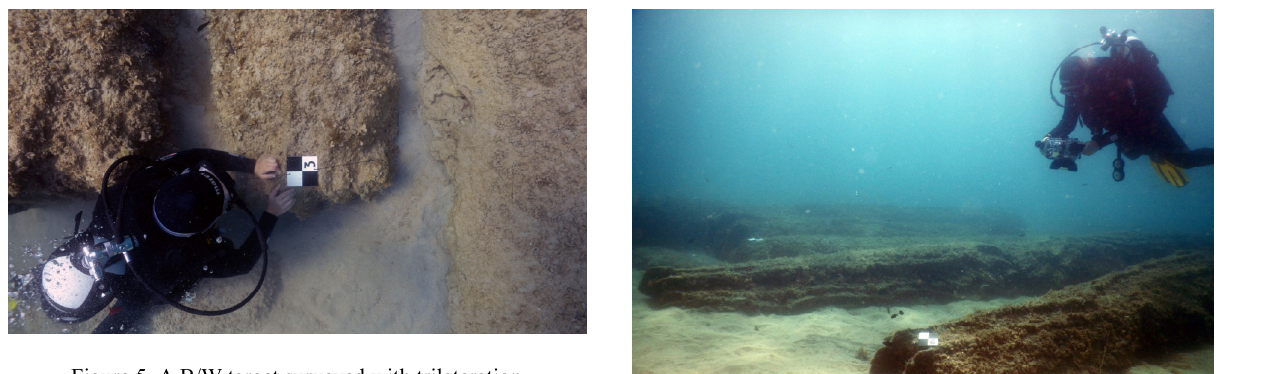
Figure 5. A B/W target surveyed with trilateration.